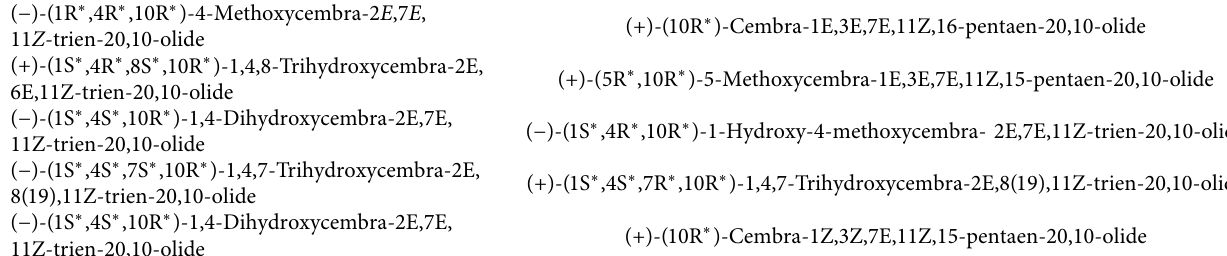
Table 2: Diterpenoids (10 cembranolides) [25].